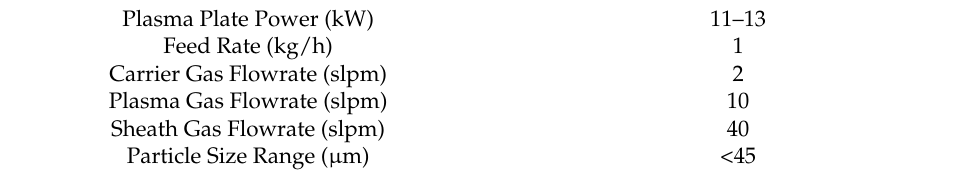
Table 1. Process parameters used for the plasma spheroidisation of Ti6Al4V